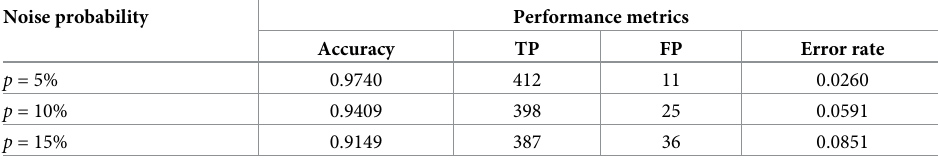
Table 5. Summary of the noise-rejection experiment results in terms of accuracy and error rate on the healty leaves of the whole